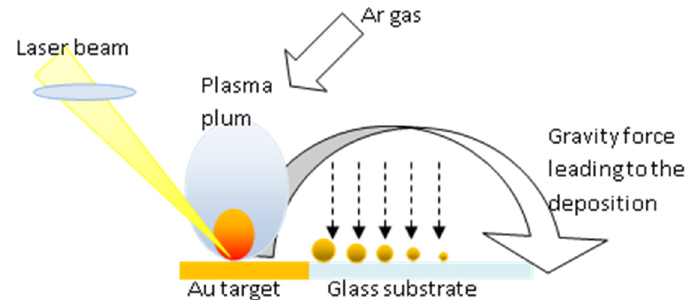
Figure 1. Schematic illustration of pulsed laser deposition Au nanoparticle arrays with a wedge- shaped profile. The film grows on the substrate located in the target plane from the backward flow of low-energy erosion torch particles. In the “back flow” mode, the separation of Au NP by their sizes occurs: large particles are deposited closer to the plasma plum axis, while smaller ones are wide apart. The structure of the films depends on the gas (e.g., argon) pressure, energy density of laser pulses, and their number and substrate position in relation to the plasma plum axis.